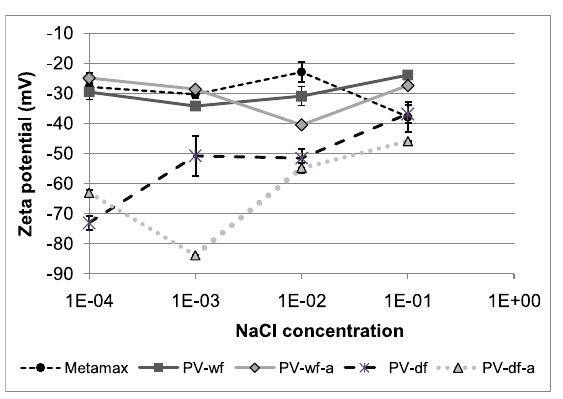
Figure 5. The effect of NaCl concentration on zeta potential of Meta- max and PV samples. The sample pHs: Metamax 5.0–5.9, PV-wf 5.9–6.8, PV-wf-a 5.9–6.9, PV-df 5.6–6.5, and PV-df- a 5.2–6.7.